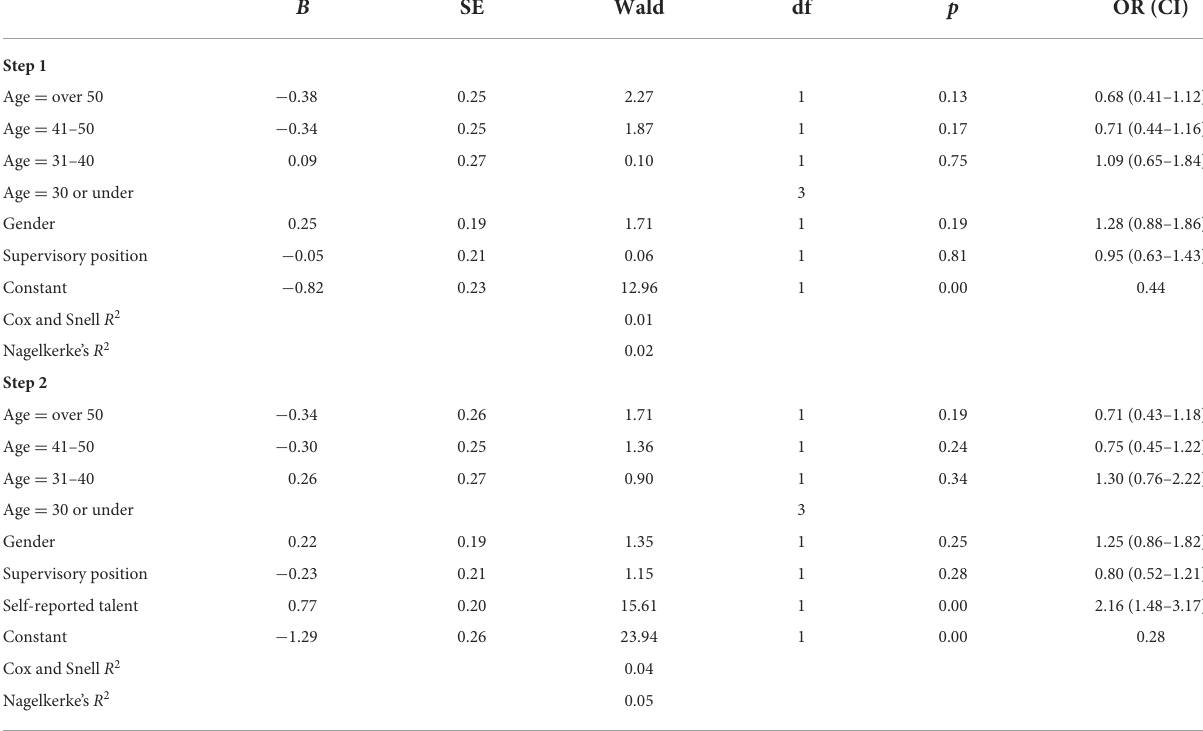
TABLE 3 Stepwise logistic regression Model 2: Perceived social climate regressed on socio-demographic control variables and self-reported talent ( N =